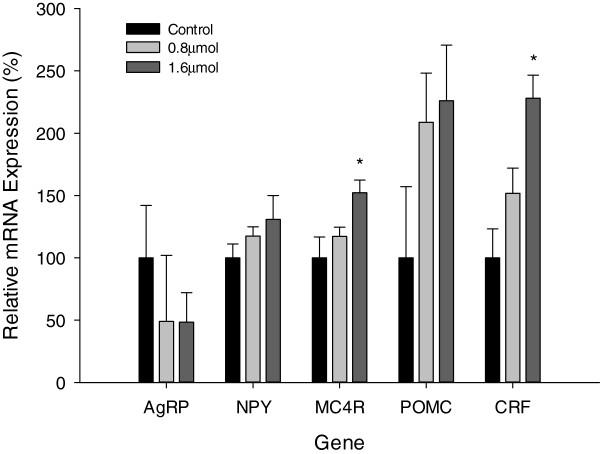
Relative mRNA expression levels for hypothalamic AgRP, NPY, MC4R, POMC and CRF 2 h after glutamate ICV injection; Data are represented as means ± S.E.M. (n = 6). Asterisk indicates significant difference from control group within each time point (P < 0.05).